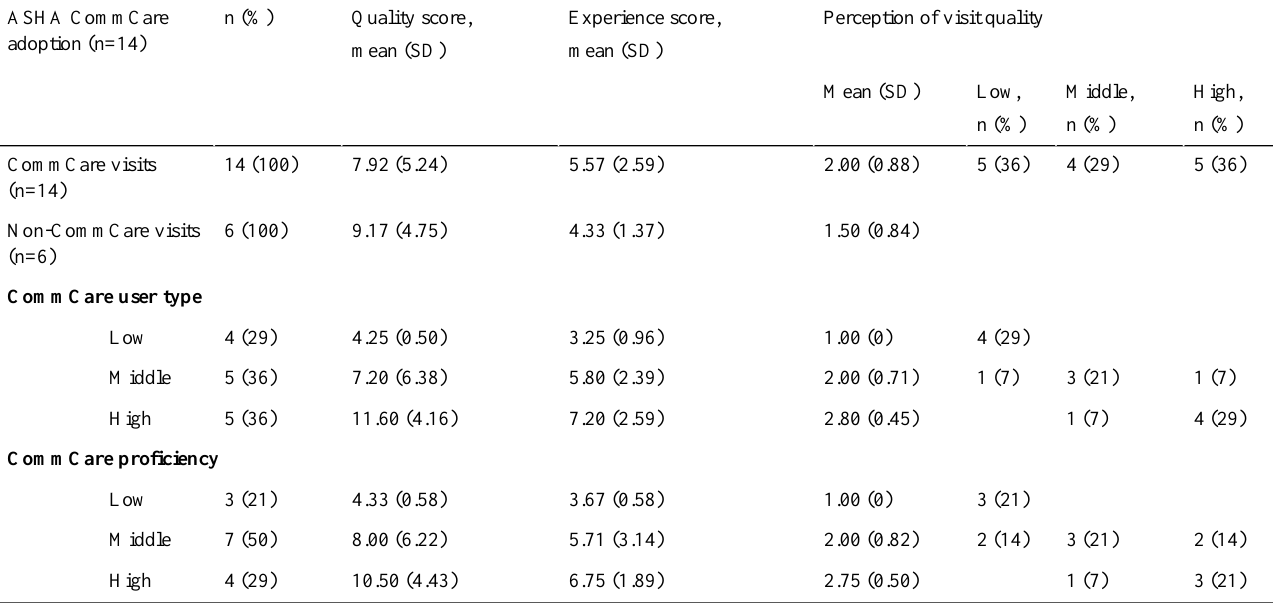
Table 4. Descriptive statistics for quality/experience of home visits for different levels of CommCare adoption.